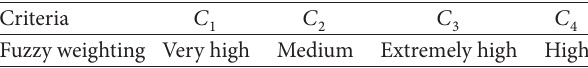
Table 4: Fuzzy weighting of criteria 𝐶 1 – 𝐶 4 . Criteria